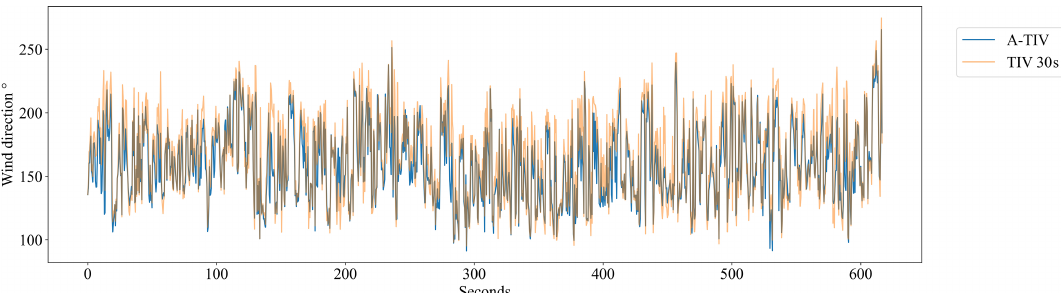
Figure B2. Qualitative comparison of A-TIV wind directions to TIV wind speeds of TURF-T1. The directions are averaged over the entire area of the turf field. TIV directions and A-TIV directions are very similar; hence this plot shows only the 30s TIV directions and the A-TIV directions. For a quantitative comparison please refer to Table